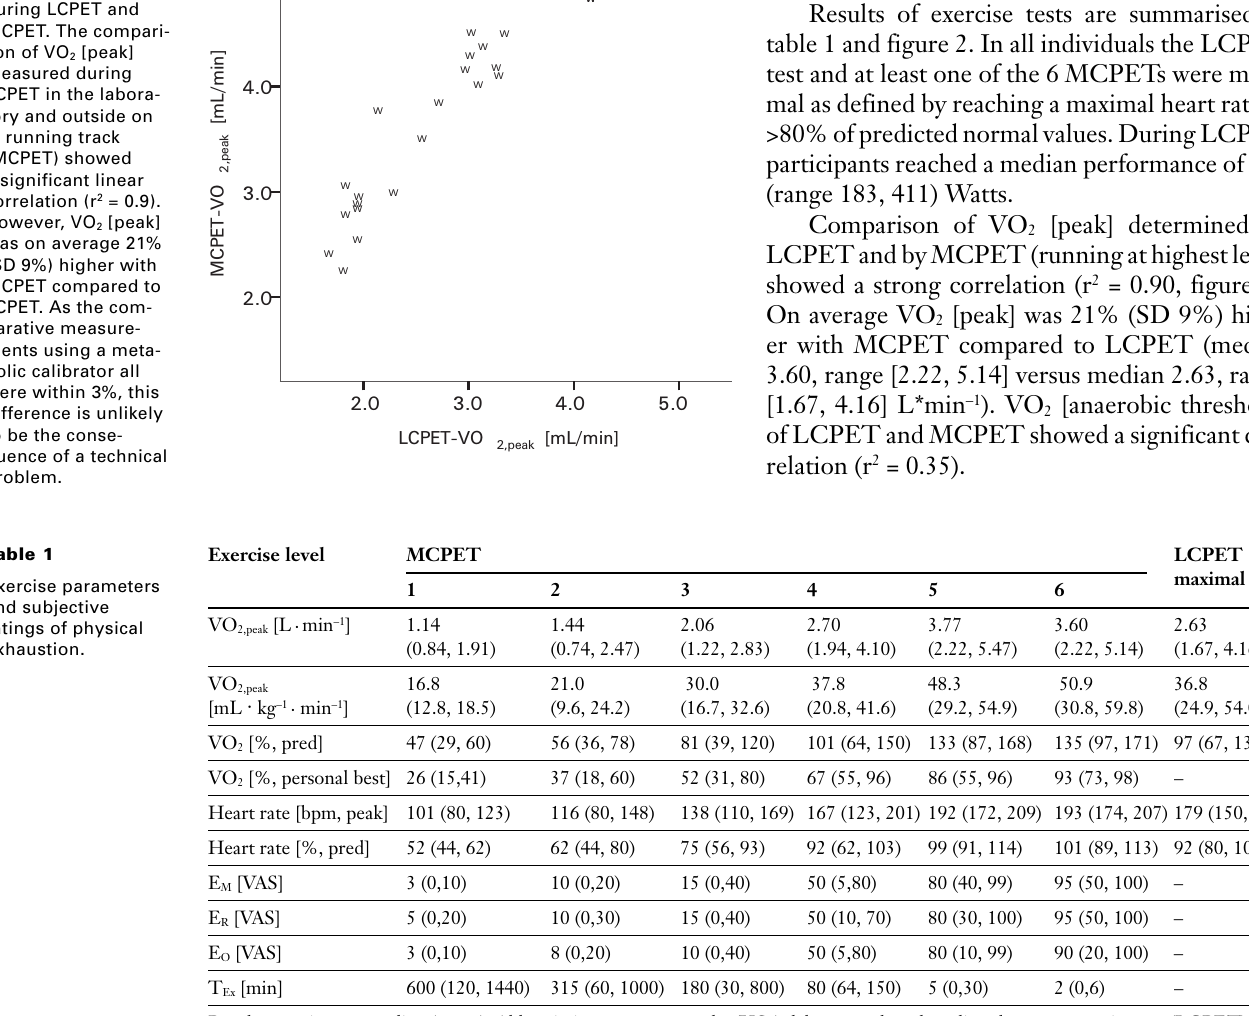
Results are given as median (range). Abbreviations: oxygen uptake (VO 2 ), laboratory-based cardiopulmonary exercise test (LCPET), mobile cardiopulmonary exercise test (MCPET), subjectively rated respiratory (Er), muscular (Em), and overall (Eo) exhaustion on a visual analogue scale (VAS), subjectively estimated time to exhaustion for a given exercise intensity (Tex).